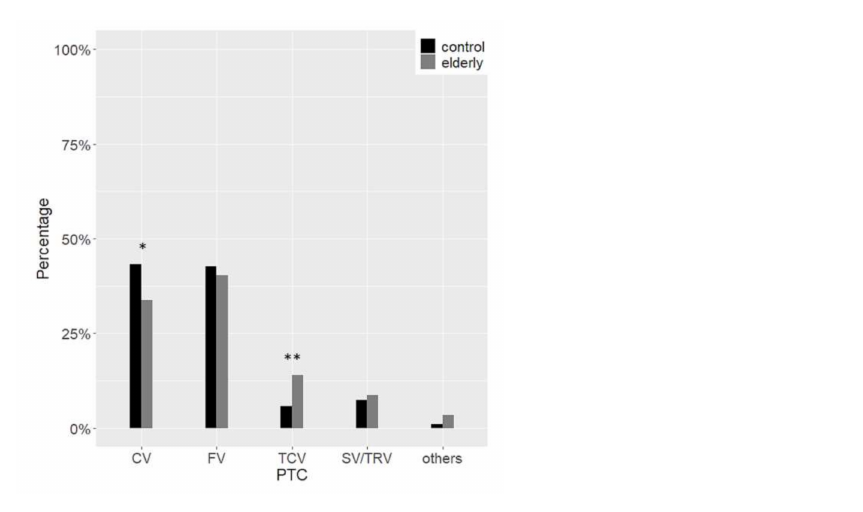
Figure 6. Differences in papillary thyroid carcinoma variants between the elderly (grey) and the control (black) group. PTC, papillary thyroid carcinoma; CV, classic variant; FV, follicular variant; TCV, tall cell variant; SV, solid variant; TRV, trabecular variant * p < 0.05 ** p < 0.01. The features of PTC and follicular carcinoma (including HCC) were compared between elderly and control patients. PTC in the elderly were larger, less frequently encapsulated and, whenever present, lymph node metastases commonly involved lateral lymph nodes. The details are reported in Table 3. Table 3. Papillary thyroid carcinoma. Differences in pathological features between elderly and control patients. Elderly ( n .